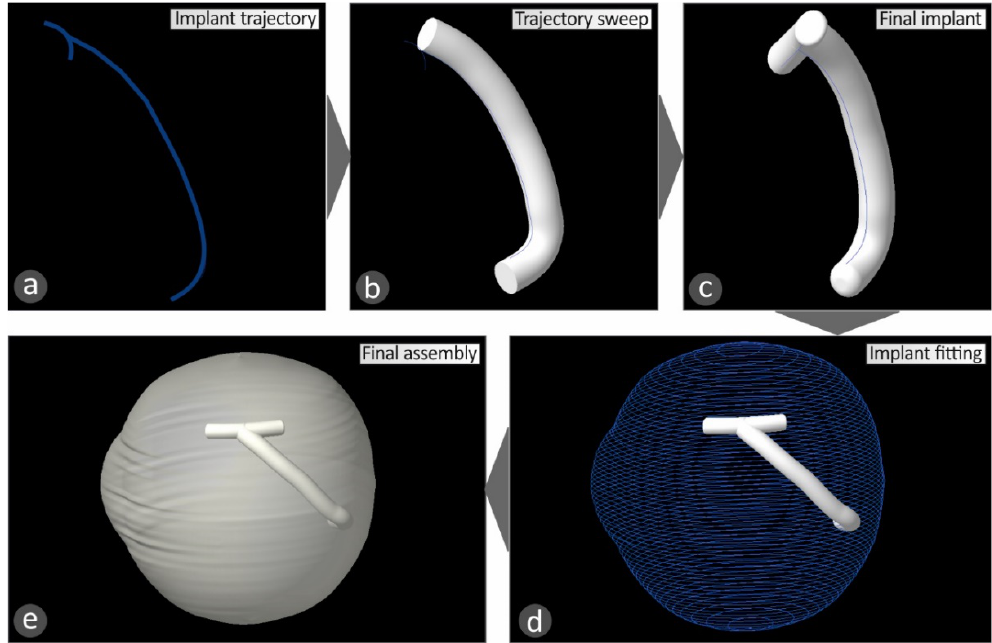
Figure 6. Steps for the development of the 3D geometric model of the customized macular buckle using a CAD software tool: ( a ) trajectory from the cloud points, ( b , c ) 3D curves, sweep geometry along the 3D curves, and finalizing of the implant design, ( d , e ) assembly of the human eye and the macular buckle using the CAD software tool to check the fit of the macular buckle to the specific human eye geometry.